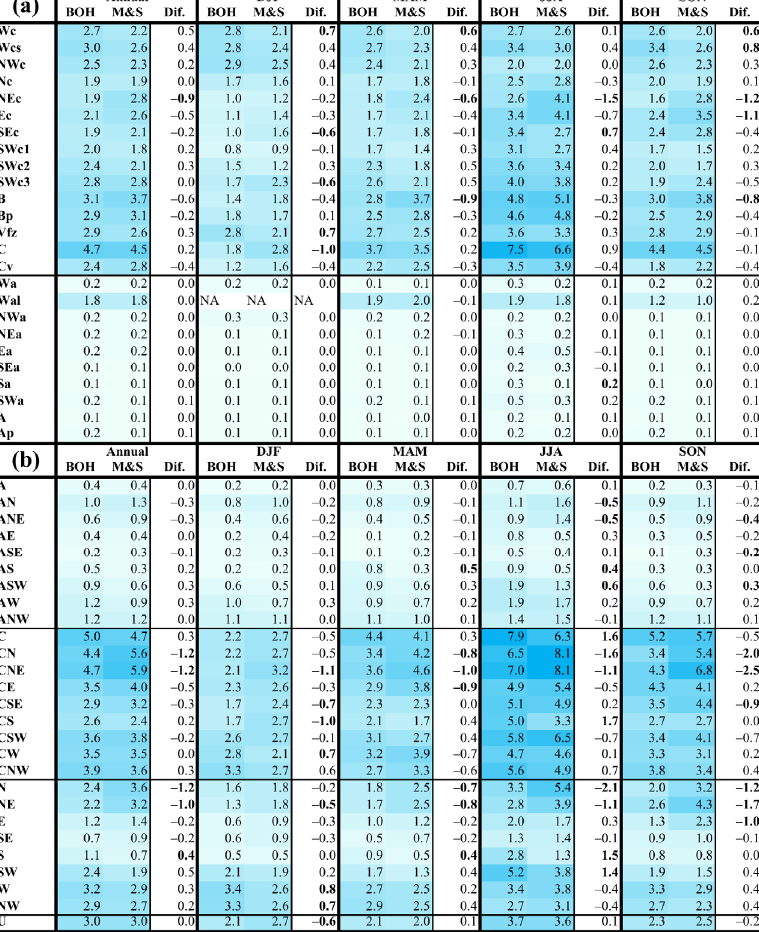
Figure 8. Mean annual and seasonal (DJF: December–February; MAM: March–May; JJA: June– August; and SON: September–November) daily precipitation totals (mm) for the individual circulation types under the CHMI ( a ) and objective ( b ) classifications in Bohemia (BOH) and Moravia and Silesia (M&S) and differences (Dif) during the 1961–2020 period. Statistically significant differences at the 0.05 significance level are denoted in bold type. The values are highlighted by the color scale of blue shades.